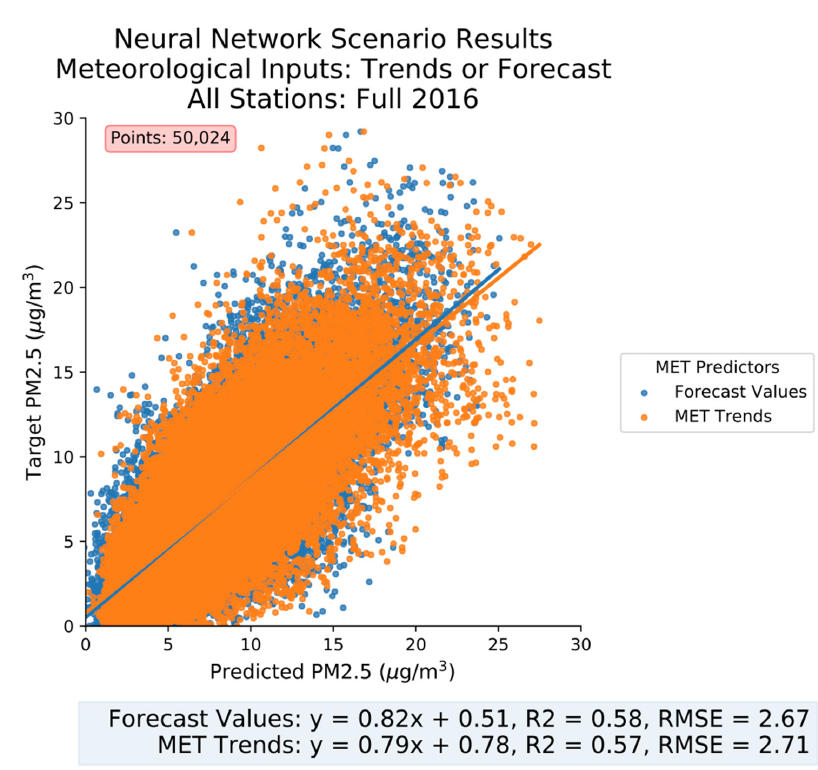
Figure 8. Regression plot for input scenarios revisited for the DNN.